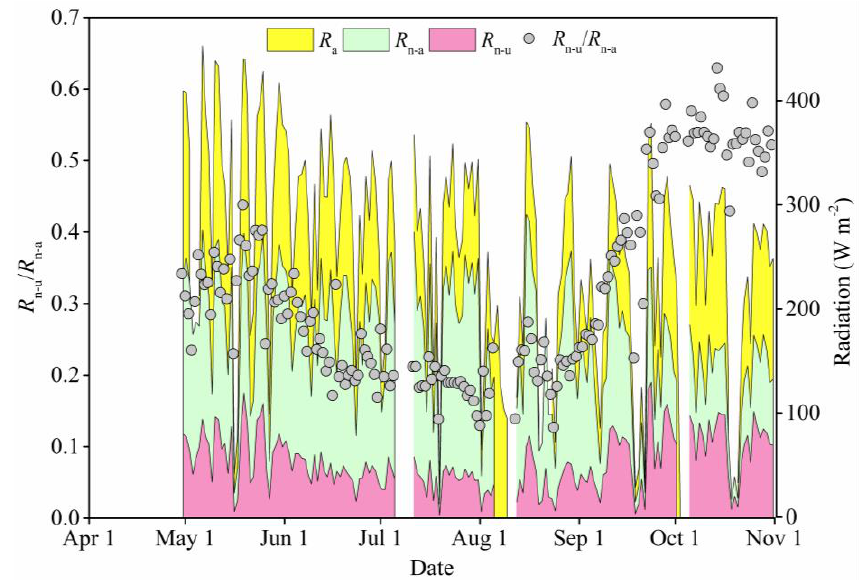
Figure 3. Seasonal variation of solar radiation ( R a ) in the experimental site, net solar radiation above ( R n-a ) and under ( R n-u ) the sample tree canopy, and the ratio between R n-u and R